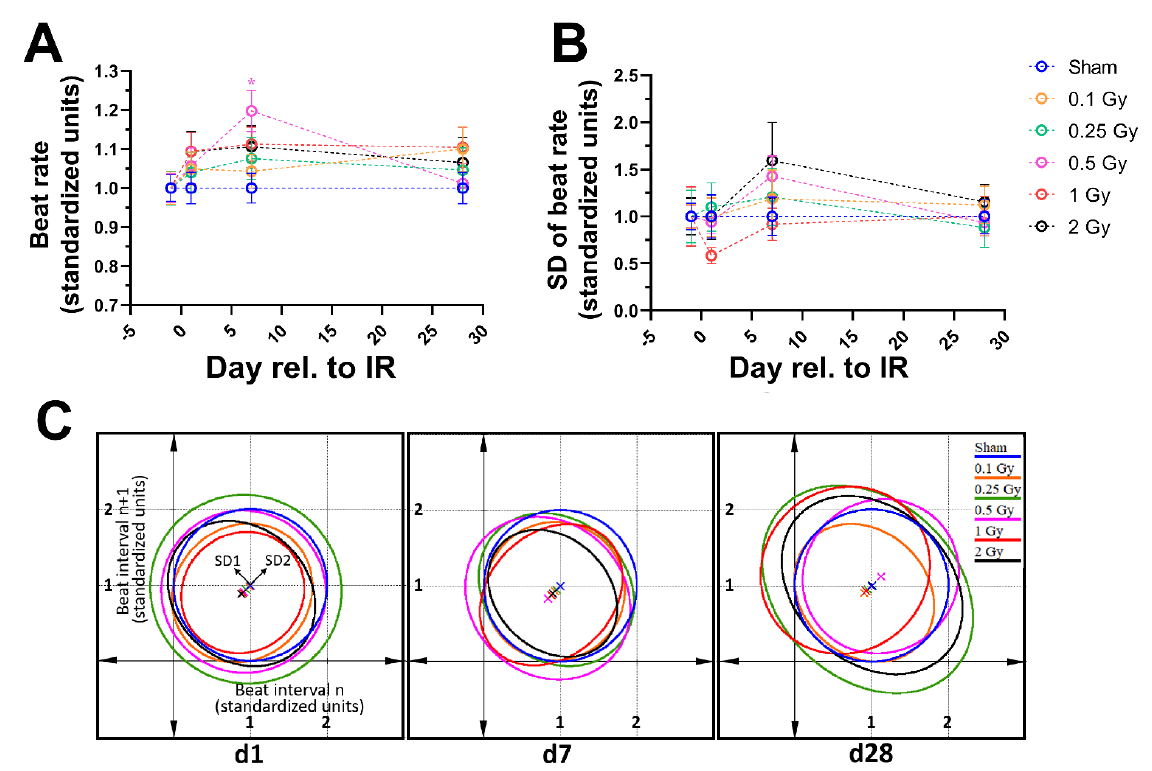
Figure 6. Functional analysis of beating hPSC-CMC reveals subtle changes in beat frequency and rhythmicity. ( A ) Beat rate and ( B ) standard deviation of individual beat rates. One-minute videos of beating hPSC-CMC were taken 1 day prior, and 1, 7, and 28 days post irradiation with different doses (0.1; 0.25; 0.5; 1; 2 Gy) of X-rays. Data were standardized to the respective measurements before irradiation and the respective controls and are shown as mean ±SEM. * p ≤ 0.05 using two-sided t -test. ( C ) Poincare plots of the measured groups 1 (d1), 7 (d7), and 28 days (d28) after irradiation. Beat intervals were normalized to the respective controls and plotted as a function of the preceding interval (N = 30–50 individual measurements of n = 3 independent experiments per irradiation dose and time point).